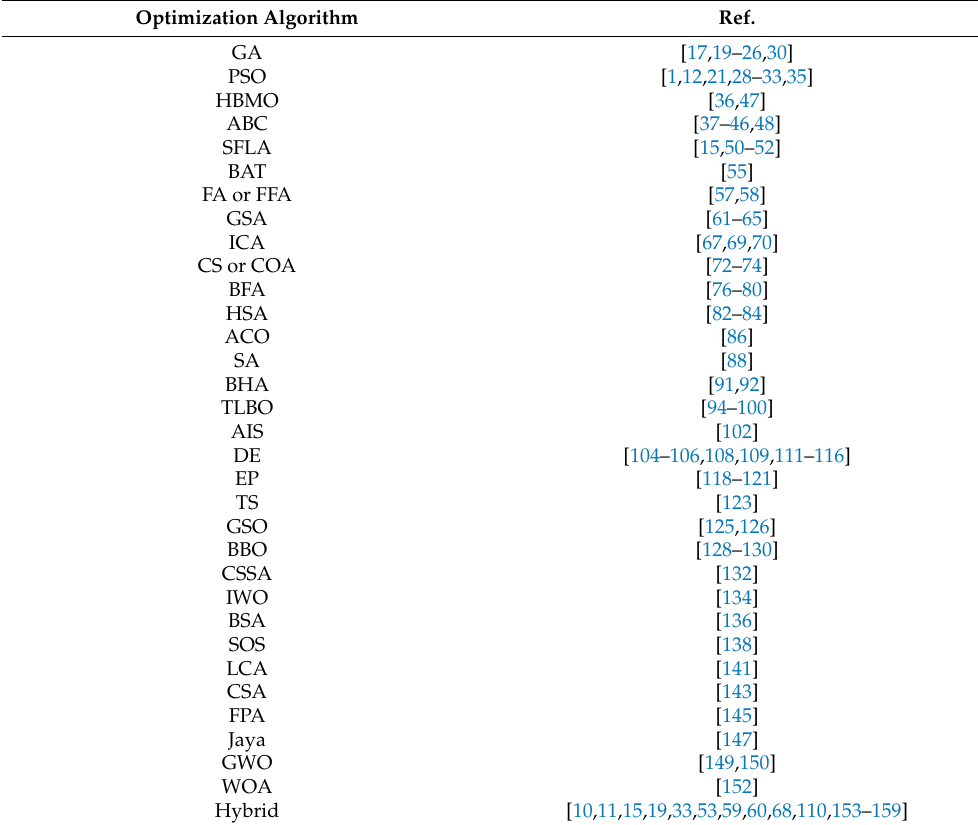
Table 2. Classification of references based on optimization algorithms. Optimization